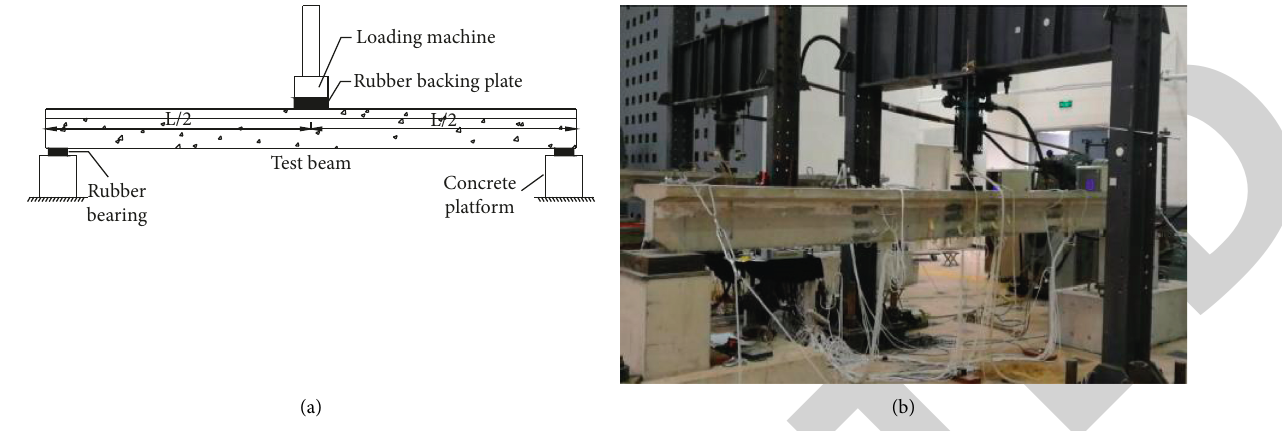
Figure 2: Layout of the test loading. (a) Loading diagram. (b) Photo of the loading layout.